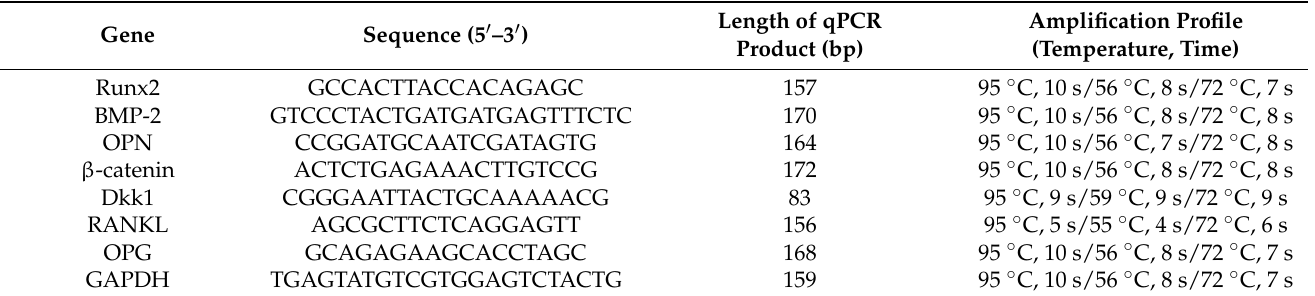
Table 1. Primer sequences, amplification profiles and the estimated length values of the qPCR product for each